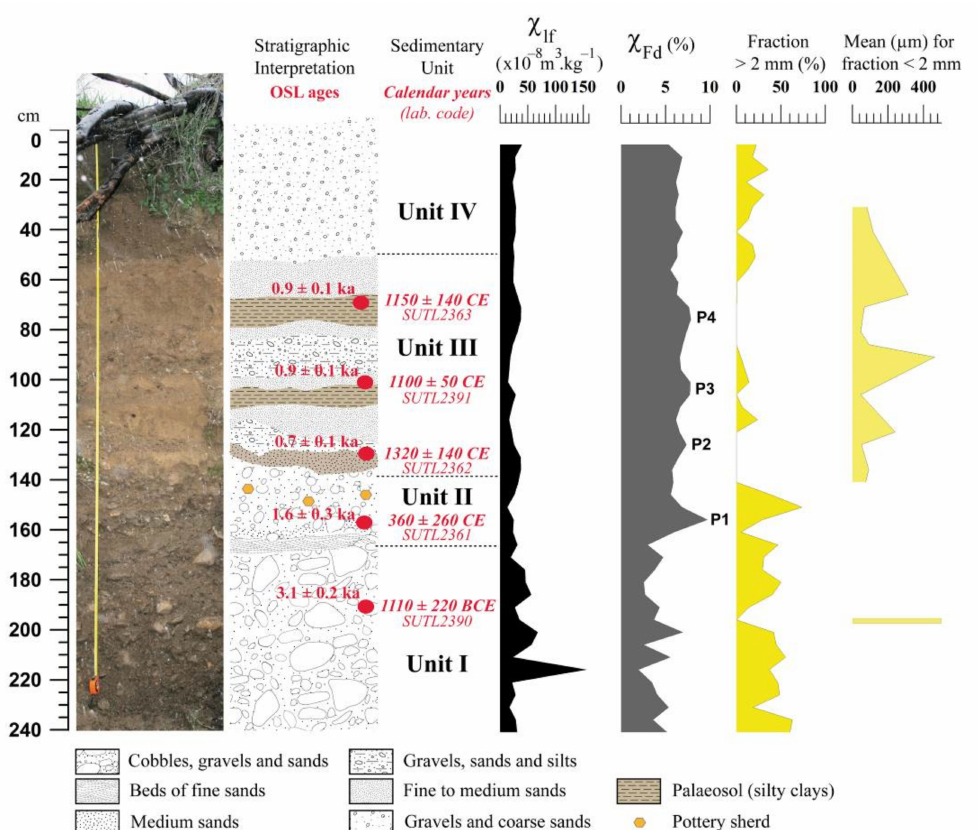
Figure 7. Stratigraphic profile studied at Pissonas. Red circles indicate the position of the OSL dating sample (lab. code is provided in Italics); Magnetic susceptibility ( χ lf ) and Frequency Dependence ( χ fd ) are expressed according to the depth; granuometry is given all along the profile using hand sieving method (yellow colour); and for the interval 130–30 cm using laser granulometry (light yellow